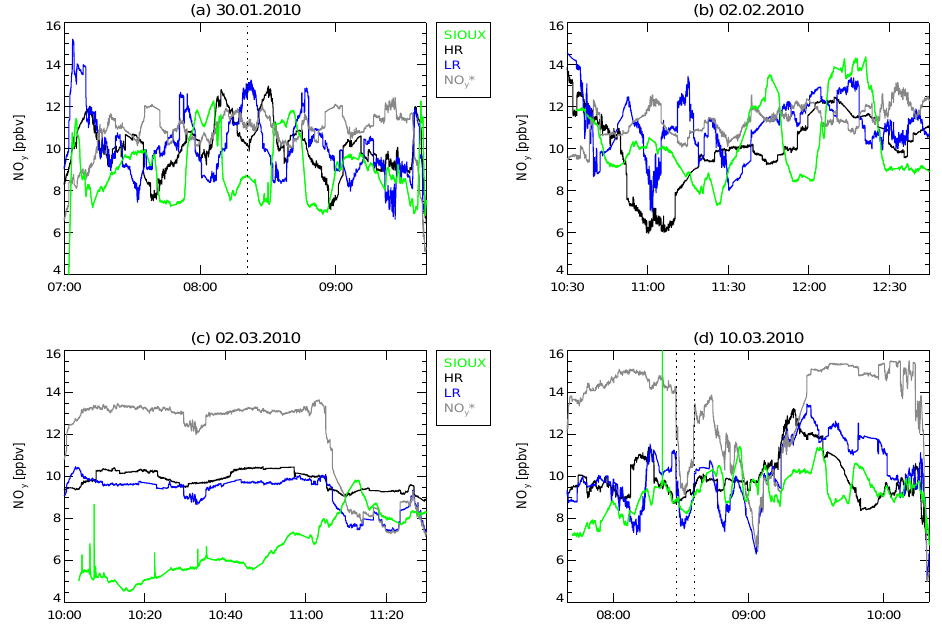
Fig. 13. Comparison of CLaMS NO y mixing ratios with SIOUX data measured aboard the Geophysica aircraft. Shown are four time sections with NO y observations inside the vortex for flights on 30 January, 2 February, 2 March and 10 March 2010. SIOUX data are displayed as green lines. CLaMS results are displayed for two different simulations: the high resolution (HR, black) and the low resolution (LR, blue). The passive NO ∗ y from CLaMS is shown as grey line. The average potential temperature of the flight segments is 432K, 433K, 447K, and 472K. In panel a the turnaround time and in panel d the observation of a filament of extra-vortex origin in the vortex (around 8:30UTC) are marked with dotted lines.